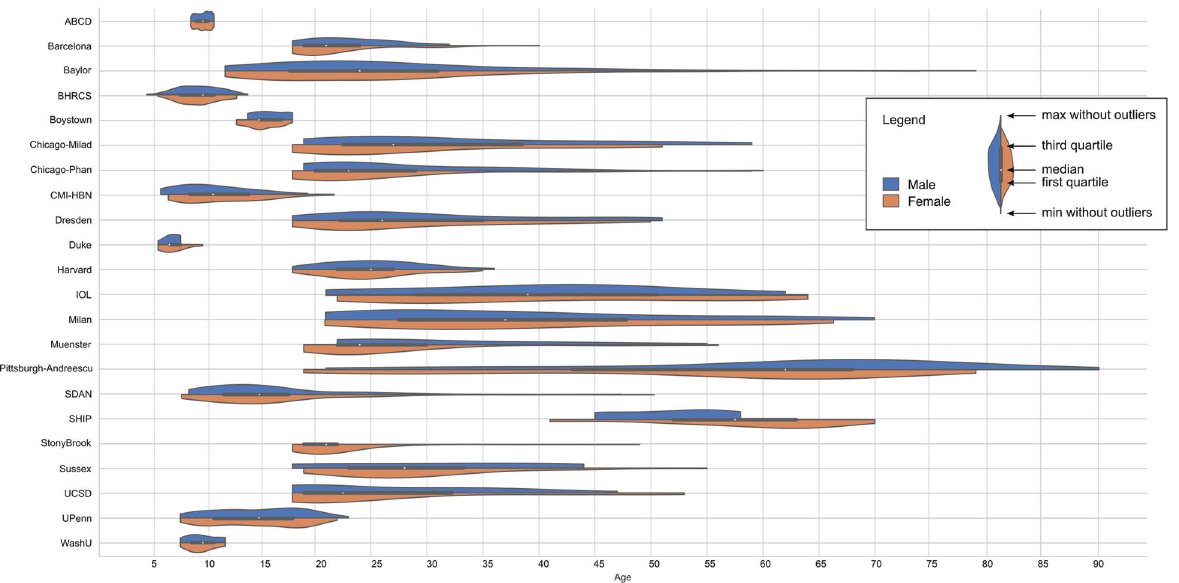
Fig. 1 Violin plots of the age distribution for all sites in the main analysis. ABCD Adolescent Brain Cognitive Development Study, BHRCS Brazilian High Risk Cohort Study, CMI-HBN Child Mind Institute Healthy Brain Network, IOL Institute of Living, SDAN Section on Development and Affective Neuroscience, SHIP Study of Health in Pomerania, UCSD University of California – San Diego, UPenn University of Pennsylvania, WashU Washington